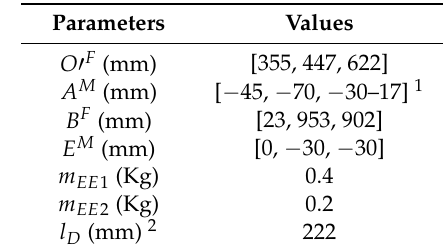
Table 7. Dimensions of the